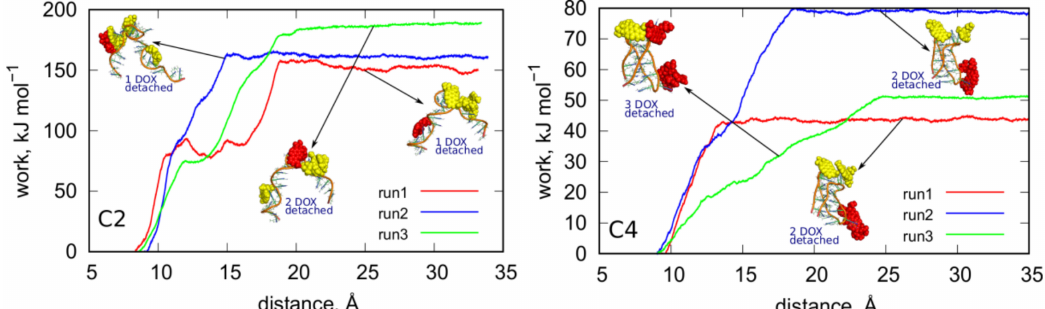
Figure 8. Works measured during the enforced detachment of DOX molecules from iM. Each curve (run1–run3) shows an independent trace started from a di ff erent initial state. These states are illustrated as the insets and are linked with the corresponding plots by arrows. The red DOX molecules are the molecules which detached as a result of the enforced detachment. The number next to a given inset indicates the number of DOX molecules which were simultaneously detached from the iM